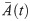
Population activity of uncoupled leaky integrate-and-fire neurons without adaptation.(A) Neurons were stimulated by a step current Iext(t) such that μ = urest + RIext(t) increased from μ = 15 mV to μ = 30 mV (top). Voltage trace of one of 500 neurons (bottom). Stationary firing statistics (rate and coefficient of variation (CV) of the interspike intervals) corresponding to the two stimuli are indicated above the step current. (B) Realizations of the population activity AN(t) for the microscopic (top) and mesoscopic (bottom, blue line) simulation. The magenta line shows the expected population rate A¯(t) given the past actual realization AN(t′) for t′ < t. (C) The power spectrum of the stationary activity AN(t) obtained from renewal theory, Eq (134), (black solid line) and from the mesoscopic simulation (blue circles). The top and bottom panel corresponds to weak (μ = 15 mV) and strong (μ = 30 mV) constant stimulation (transient removed).